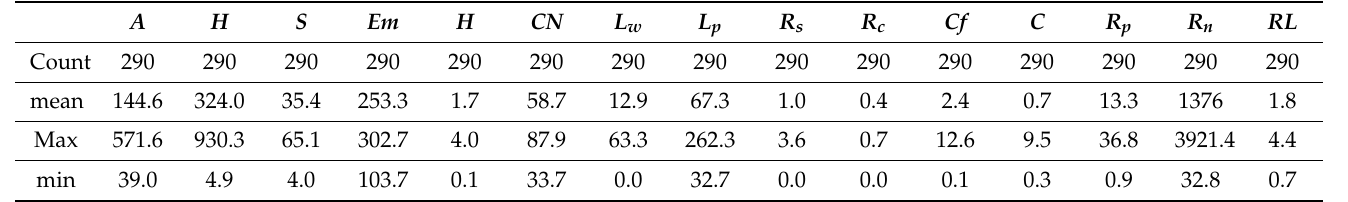
Table 1. Summary of independent